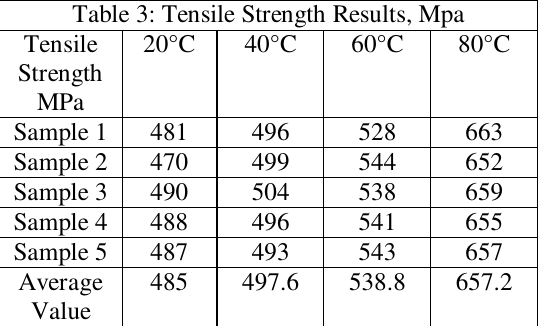
Table 3: Tensile Strength Results, Mpa